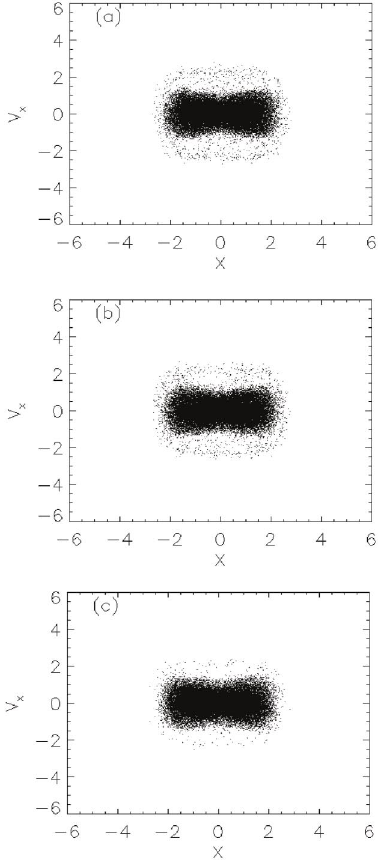
FIG. 11. Oscillation of the rms width of the beam with non- linear focusing showing collimation for (cid:4) (cid:1) (cid:4) a (cid:5) 1.5, (b) 1.35, (c) 1.2.